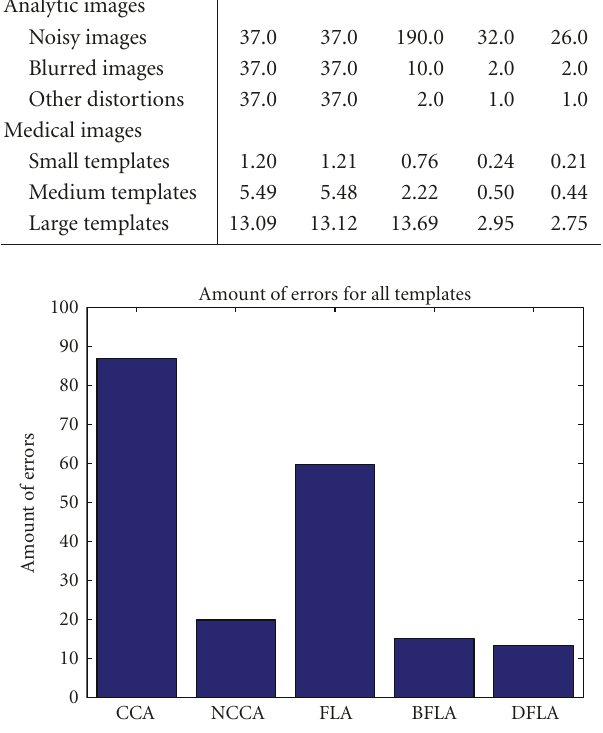
Figure 11: Amount of incorrect detected templates in percent for all images and all